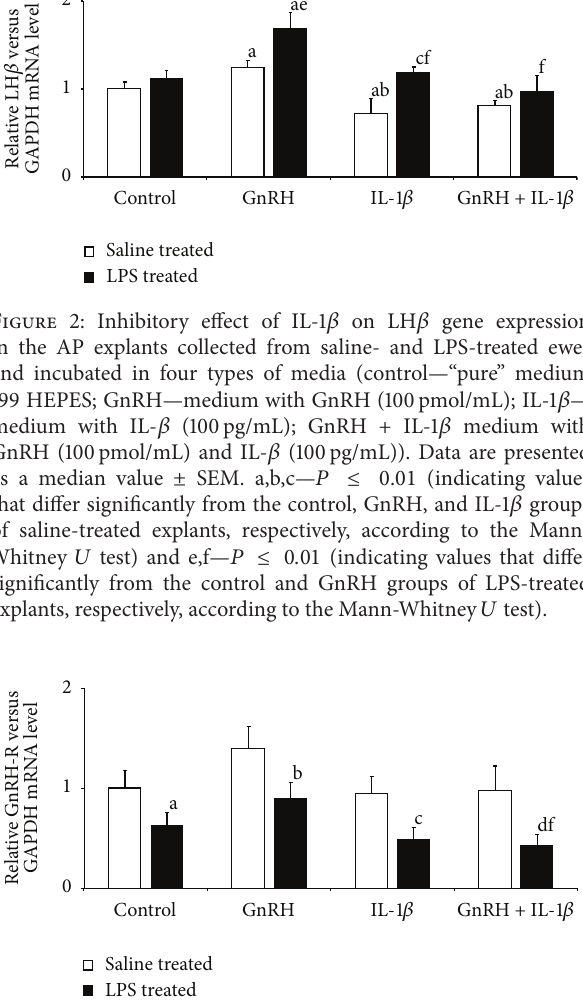
Figure 3: GnRH-R gene expression in the AP explants collected from saline- and LPS-treated ewes and incubated in four types of media (control—“pure” medium 199 HEPES; GnRH—medium with GnRH (100pmol/mL); IL-1 𝛽 —medium with IL- 𝛽 (100pg/mL); GnRH + IL-1 𝛽 medium with GnRH (100pmol/mL) and IL- 𝛽 (100pg/mL)). Data are presented as a median value ± SEM. a,b,c,d— 𝑃 ≤ 0.01 (indicating values that differ significantly from the control, and GnRH, IL-1 𝛽 , GnRH + IL-1 𝛽 groups of saline-treated explants, respectively, according to the Mann-Whitney 𝑈 test) and f— 𝑃 ≤ 0.01 (indicating values that differ significantly from the GnRH group of LPS-treated explants, respectively, according to the Mann- Whitney 𝑈 test).